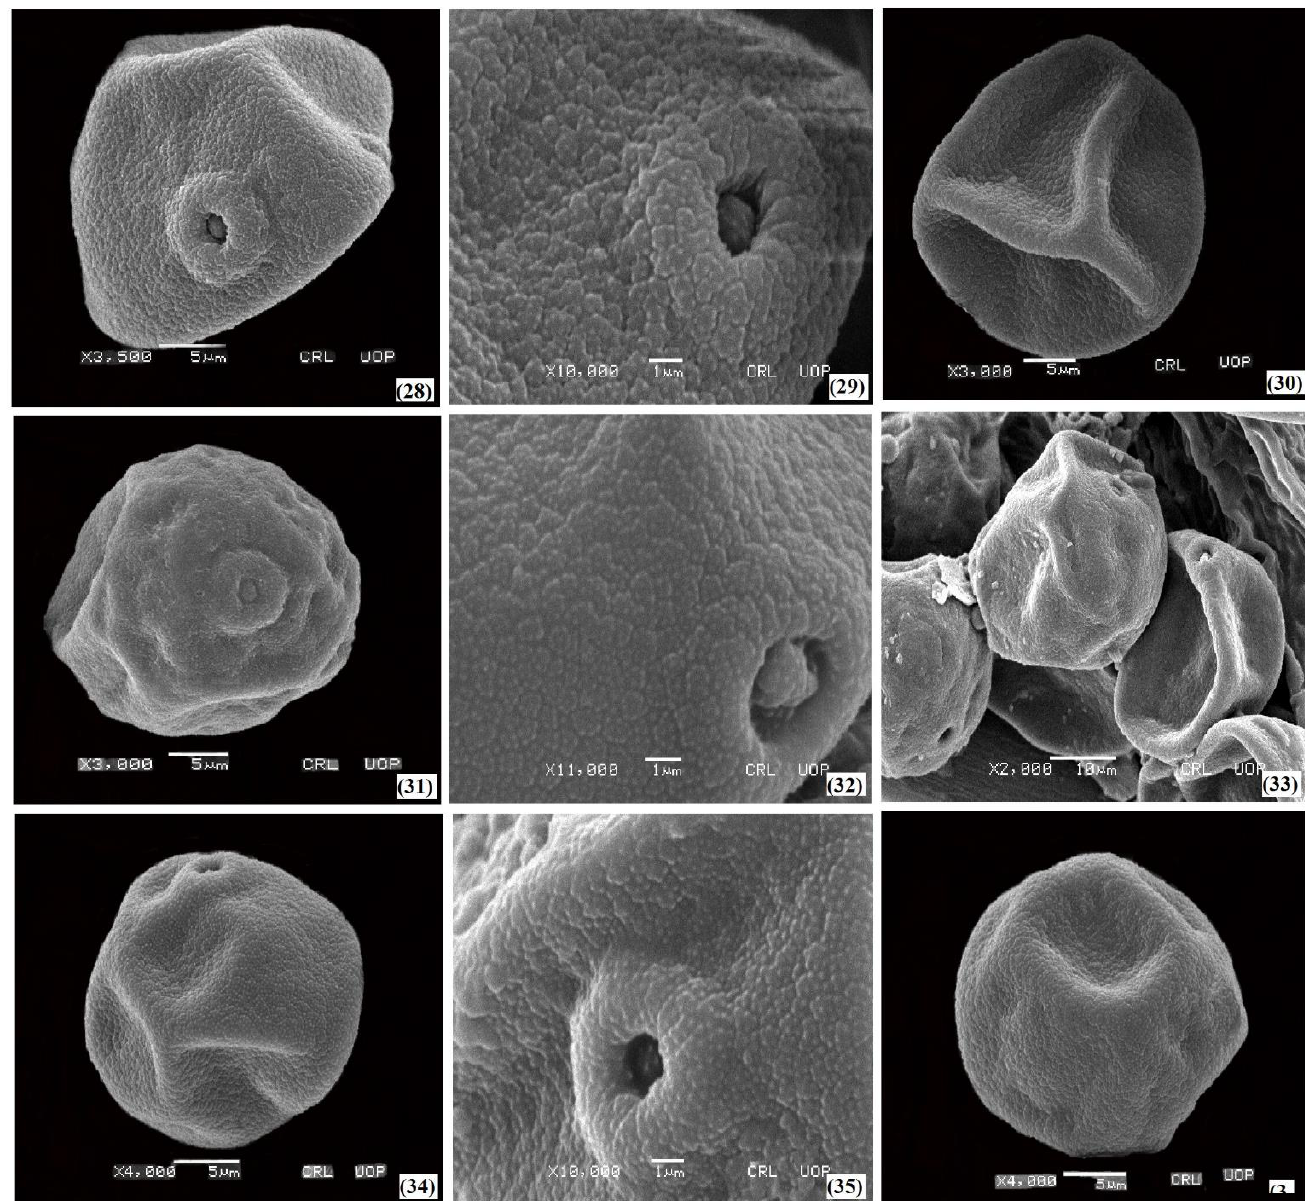
Figure 5. SEM pollen micrographs of salt tolerant grasses. Saccharum griffithii (28, 29 & 30), Saccharum ravennae (31, 32 & 33), Saccharum spontaneum (34, 35 & 36).